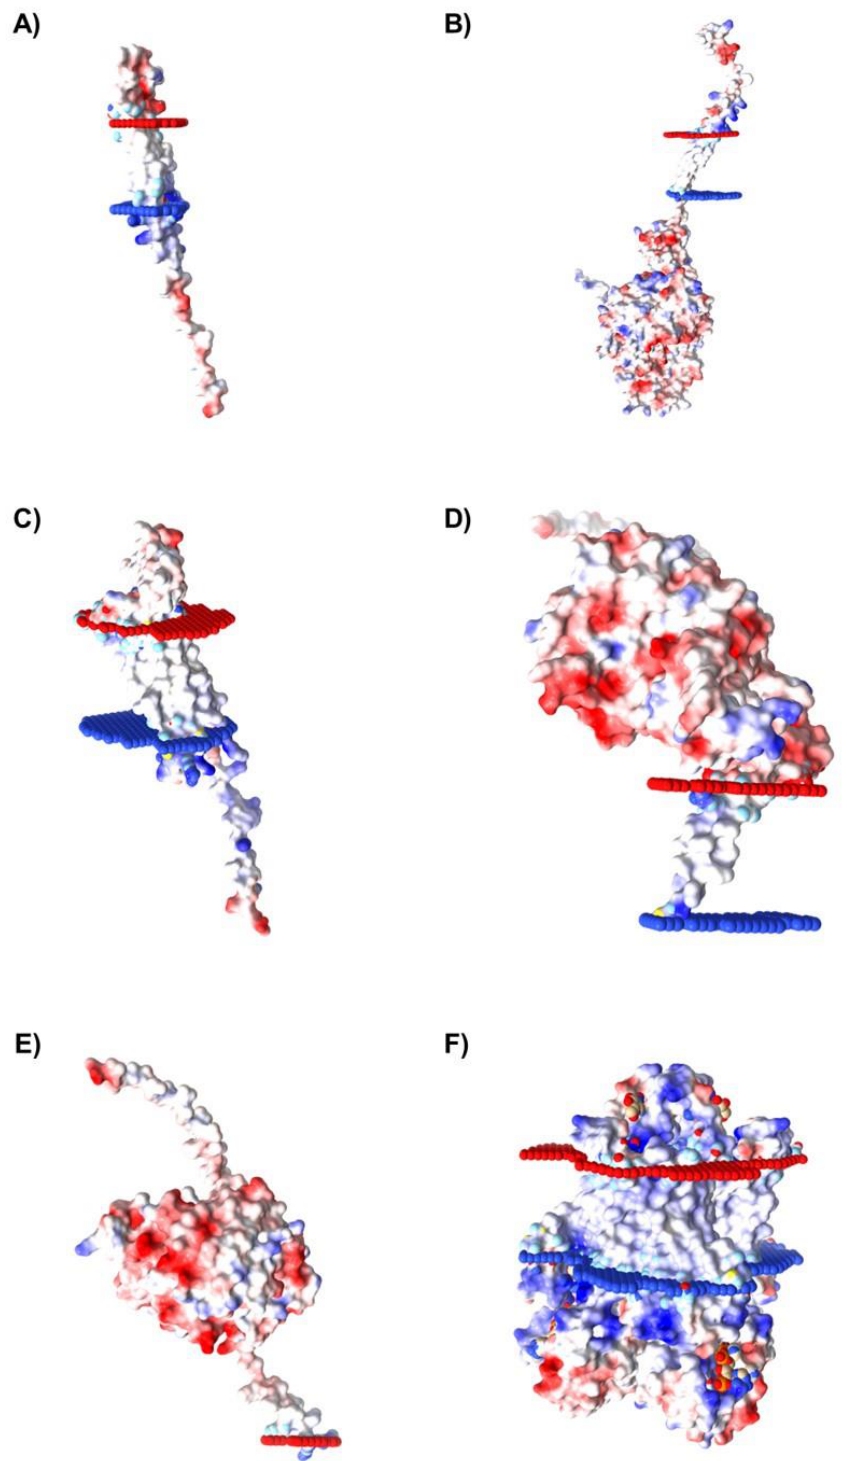
Figure 7. Membrane regions’ spatial distribution and electrostatic potential determination of proteins identified for Caov-3 cell line. The proteins selected for Caov-3 cells were: ( A ) FXYD3, ( B ) ITGB2, ( C ) CLDN7, ( D ) ALPP, ( E ) SMPDL3B, and ( F ) STEAP4. For the spatial orientation, the red portion indicates the extracellular region, and the blue portion indicates the intracellular region. For the electrostatic potential determination, blue color indicates a positive charge and red color indicates a negative charge.